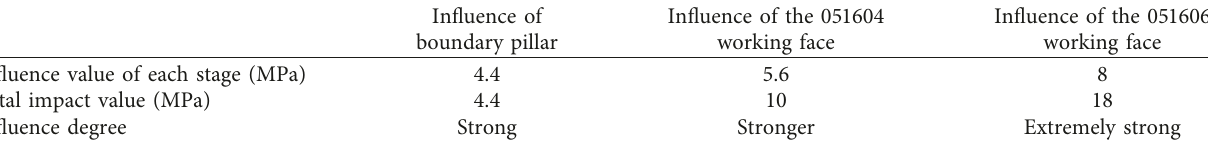
Table 3: Analysis of principal stress difference on the rock surrounding the roof during